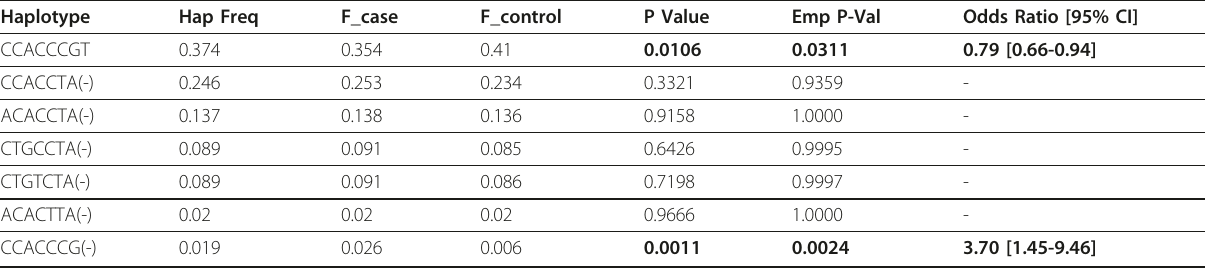
The eight marker haplotype, as ordered in the table, consists of: rs3744165, rs12450046, rs8074277, rs35653278, rs34188981, rs12948179, rs12938126, rs35156590. Hap Freq, overall haplotype frequency; F_case, haplotype frequency in cases; F_control, haplotype frequency in controls; Emp P-Val, empiric p-value calculated by permutation testing.